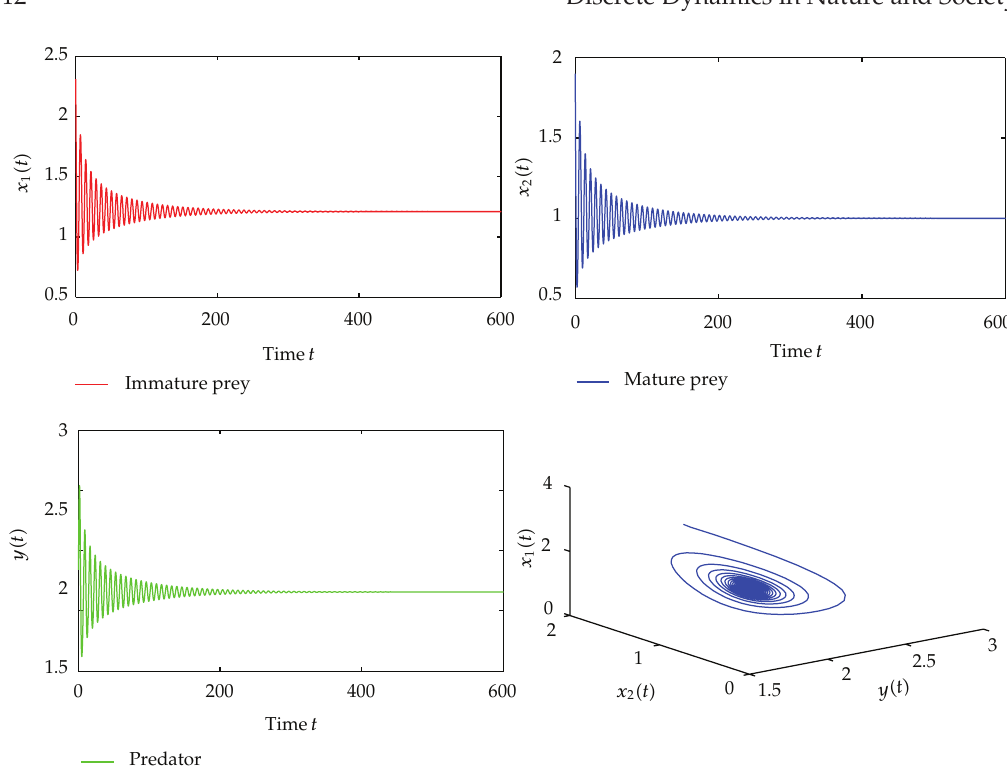
Figure 5: E 0 is locally asymptotically stable for τ (cid:6) 0 . 3900 < τ 0 (cid:6) 0 . 4178 with initial value “2.31; 1.9;